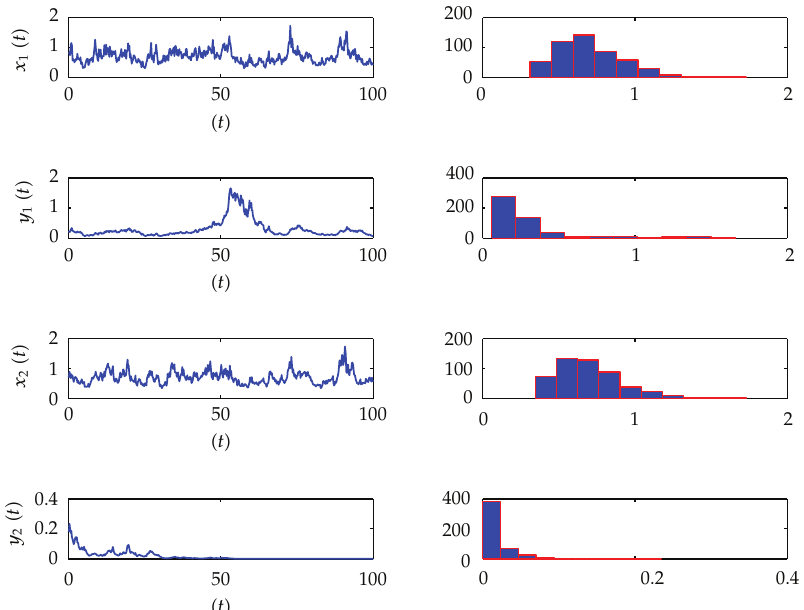
Figure 4: The solution of stochastic system with large white noise and its histogram: σ 11 (cid:5) 0 . 4 ,σ 12 (cid:5) 0 . 3 ,σ 21 (cid:5) 0 . 3 ,σ 22 (cid:5) 0 . 4. The fluctuations on the left figures are more intense and histogram distribution is not concentrated comparing with Figure